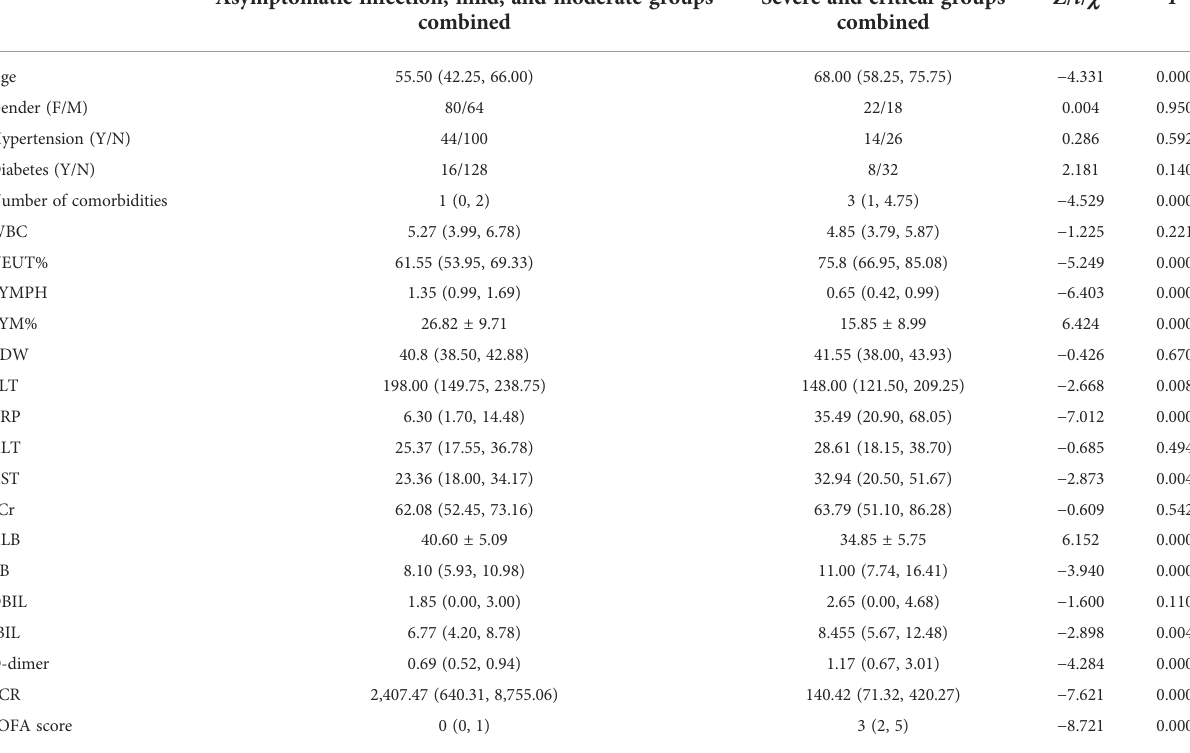
TABLE 5 Comparison of demographic and clinical baseline data between asymptomatic infection, mild, and moderate groups combined and severe and critical groups combined. Asymptomatic infection, mild, and moderate groups